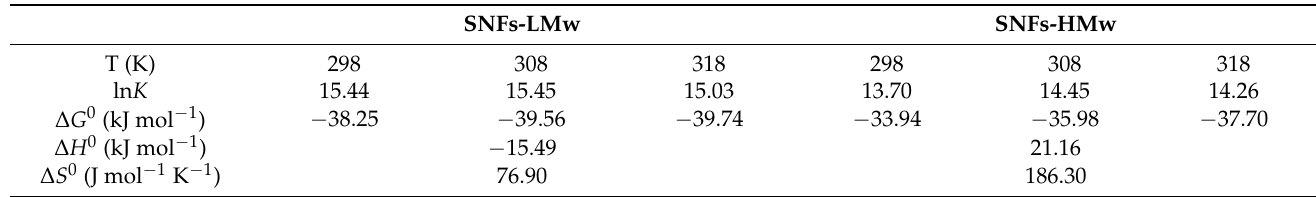
Table 5. Thermodynamic parameters of MB adsorption on SNFs-LMw and SNFs-HMw.